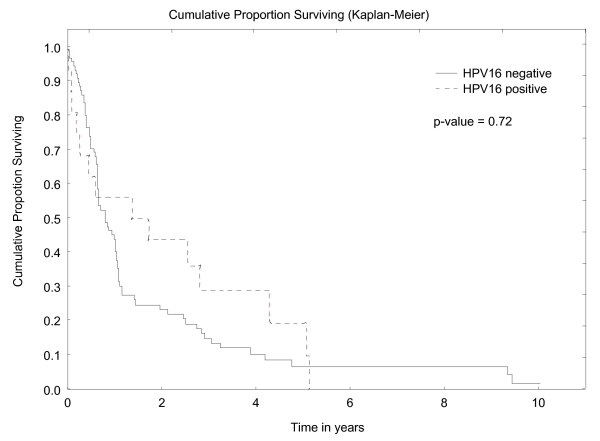
Survival analysis including all patients based on detection of amplified HPV 16 DNA in the tumor samples.